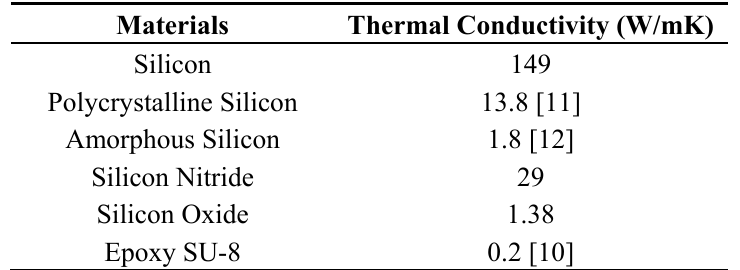
Table 1. Thermal conductivity of microbolometer structure